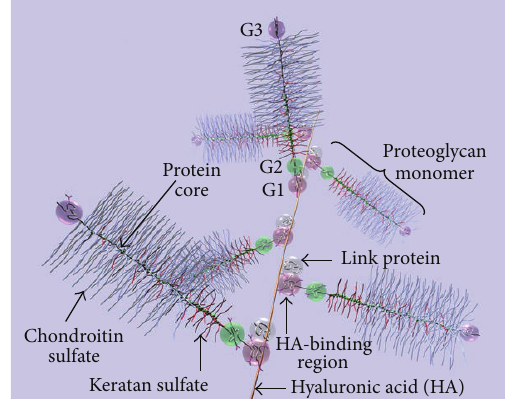
Figure 2: Diagram of part of an aggrecan aggregate. G1, G2, and G3 are globular, folded regions of the central core protein. Proteoglycan aggrecan showing the noncovalent binding of proteoglycan to HA with the link